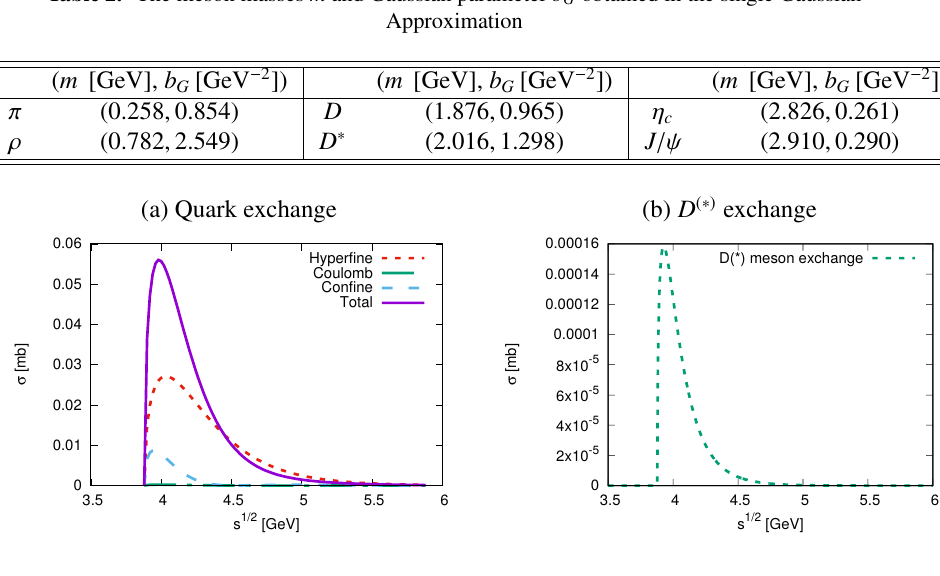
cross sections by the quark exchange model and the meson exchange model are displayed in Figs. 2 (a) and (b), respectively. In Fig. 2 (a), the large contribution from the spin-spin